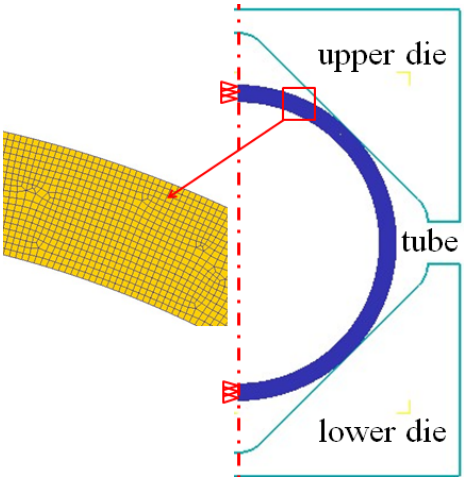
Figure 2. Finite element model of the square